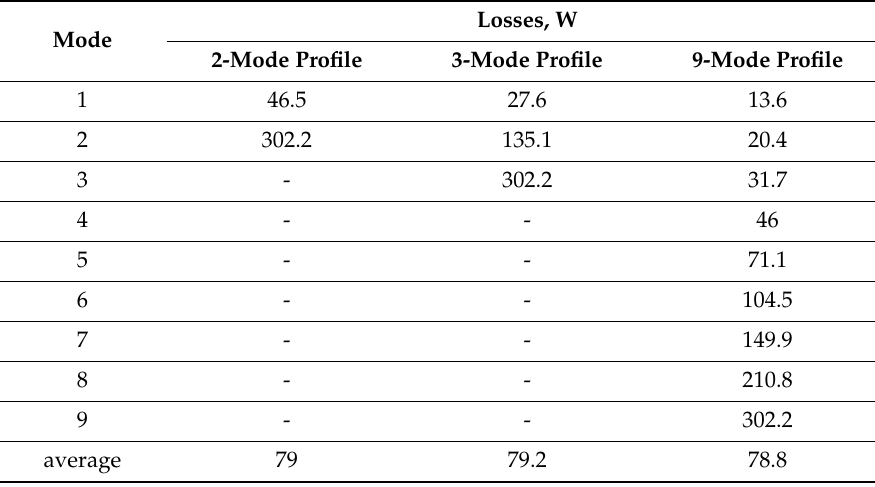
Table 8. The calculated losses of the optimized FSG design.